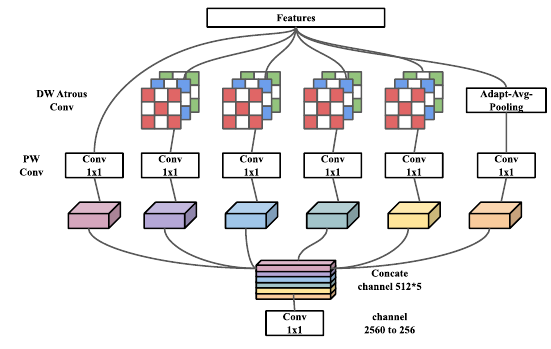
Figure 5. Depth-Wise-Wide-ASPP Module.